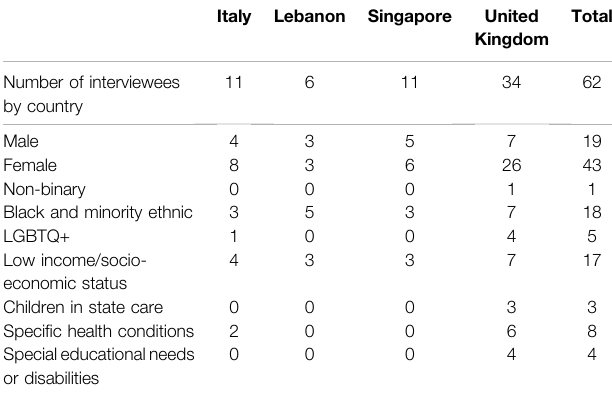
TABLE 1 | Participants ’